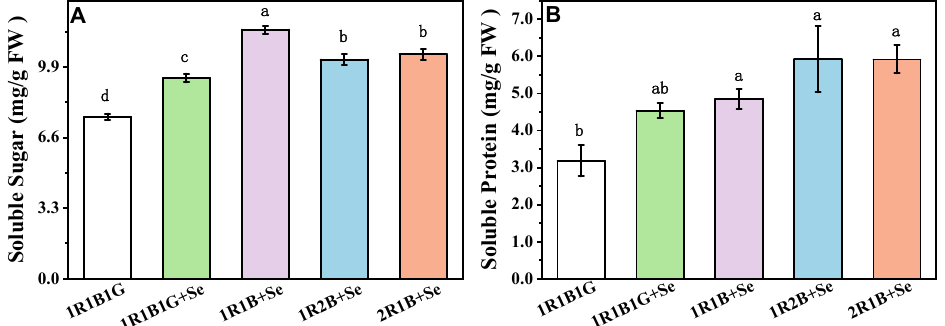
Figure 1. The contents of soluble sugars ( A ) and soluble protein ( B ) of broccoli sprouts grown under a combination of selenium and LED light quality treatments. The letters marked in all figures indicate the significance of the di ff erence ( p ≤ 0.05, Duncan’s